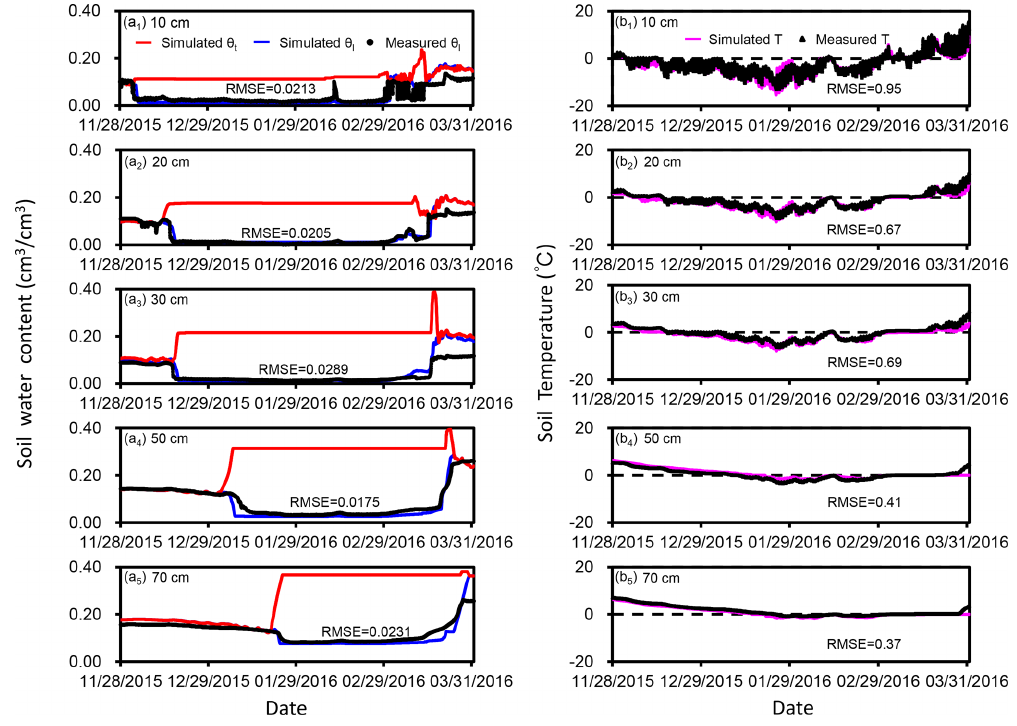
Figure 5. The observed and simulated liquid water content and simulated total water content ( θ t ) ( a 1 − a 5 ) and soil temperature ( b 1 − b 5 ) at the five different depths within the frozen zone during the freezing–thawing cycle. The RMSEs of liquid water content and soil temperature are also listed.